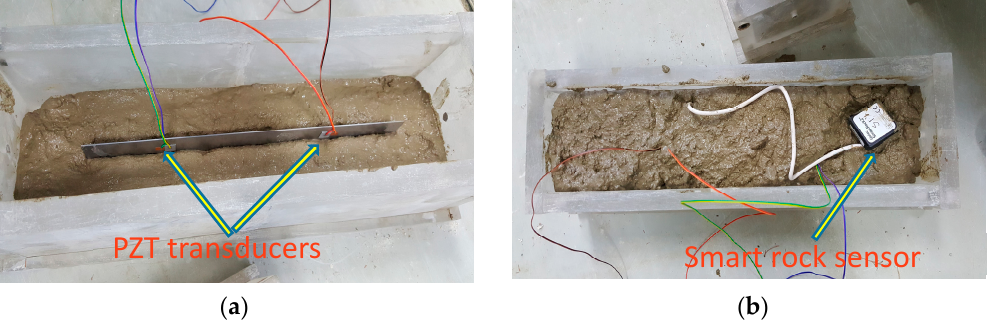
Figure 3. ( a ) Embedded PZT transducers in concrete specimen and ( b ) allocation of SmartRock (temperature sensor).